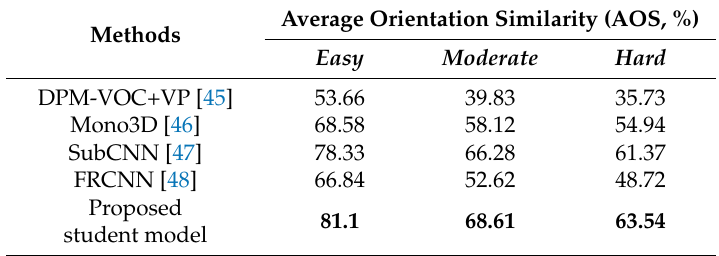
Table 3. Comparison of the average orientation similarity (AOS) for the proposed method and a deep neural network-based approach using the KITTI dataset. (We referred to the results of four comparison methods from the experimental evaluations in